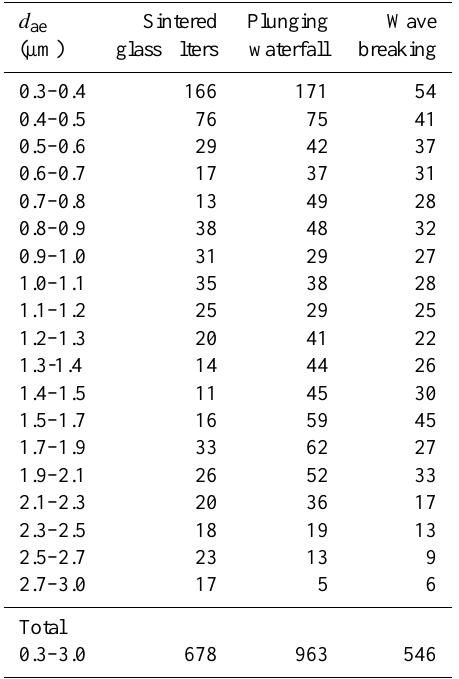
Table 1. Tabulated number of particles analyzed by SEM-EDX in each size